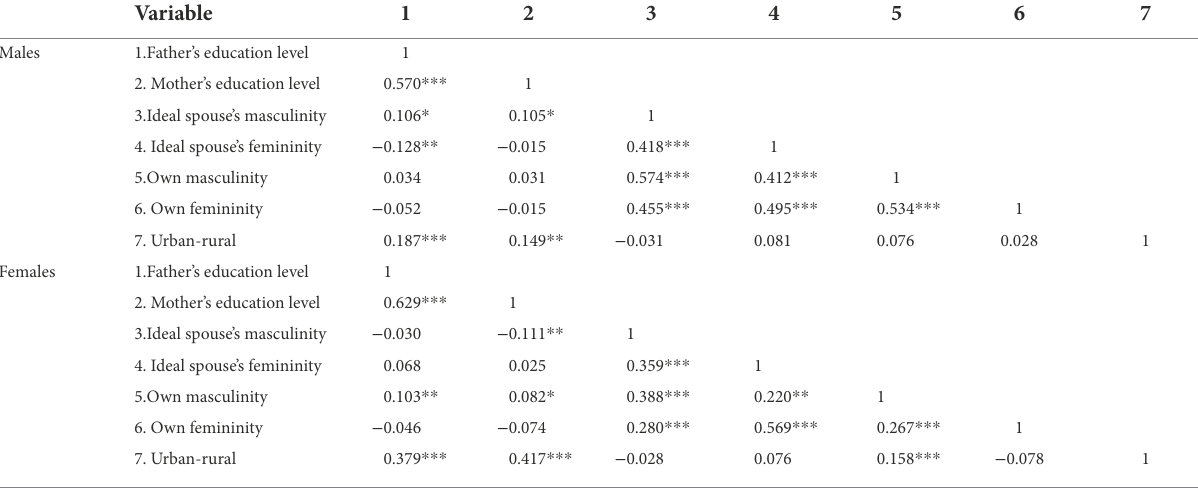
TABLE 4 Correlations between education and for explicit mate preference.